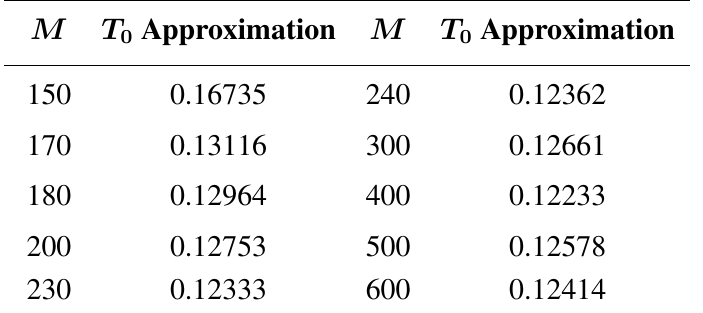
Table 6. Approximations of T error curves for various M . The exact value T for M ranging from 200 to 600.